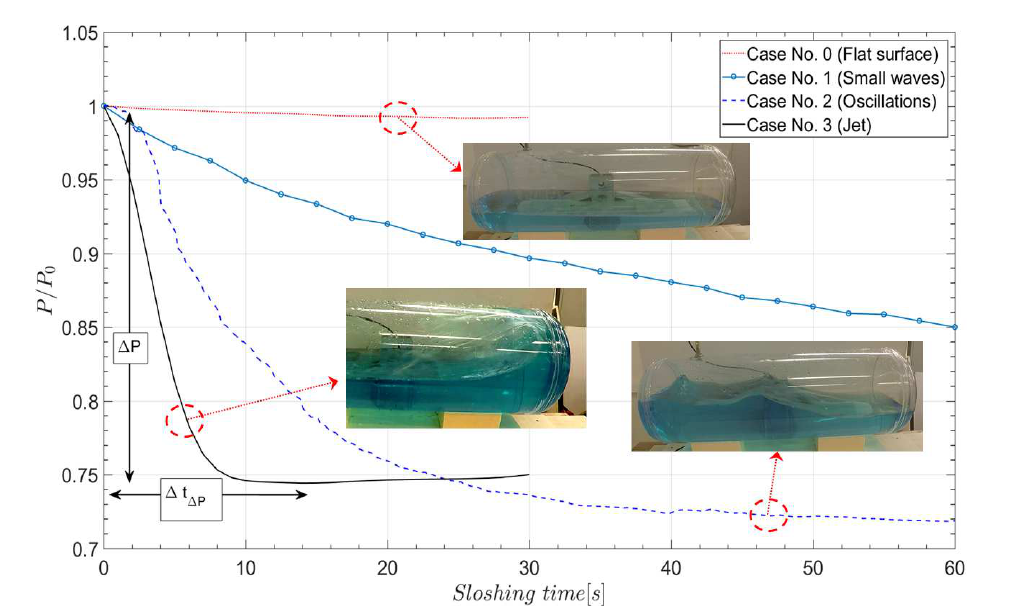
Figure 6. Measured pressure drop and its dependency on the motion frequency.